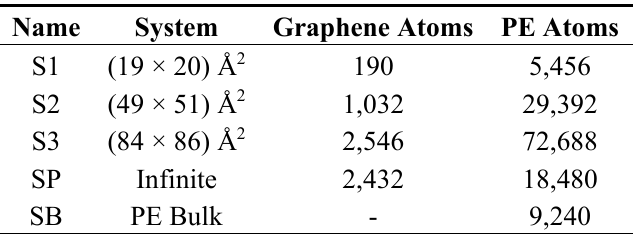
Table 1. Details for the simulated systems: Name; Size of graphene sheet; Number of graphene atoms; Number of PE